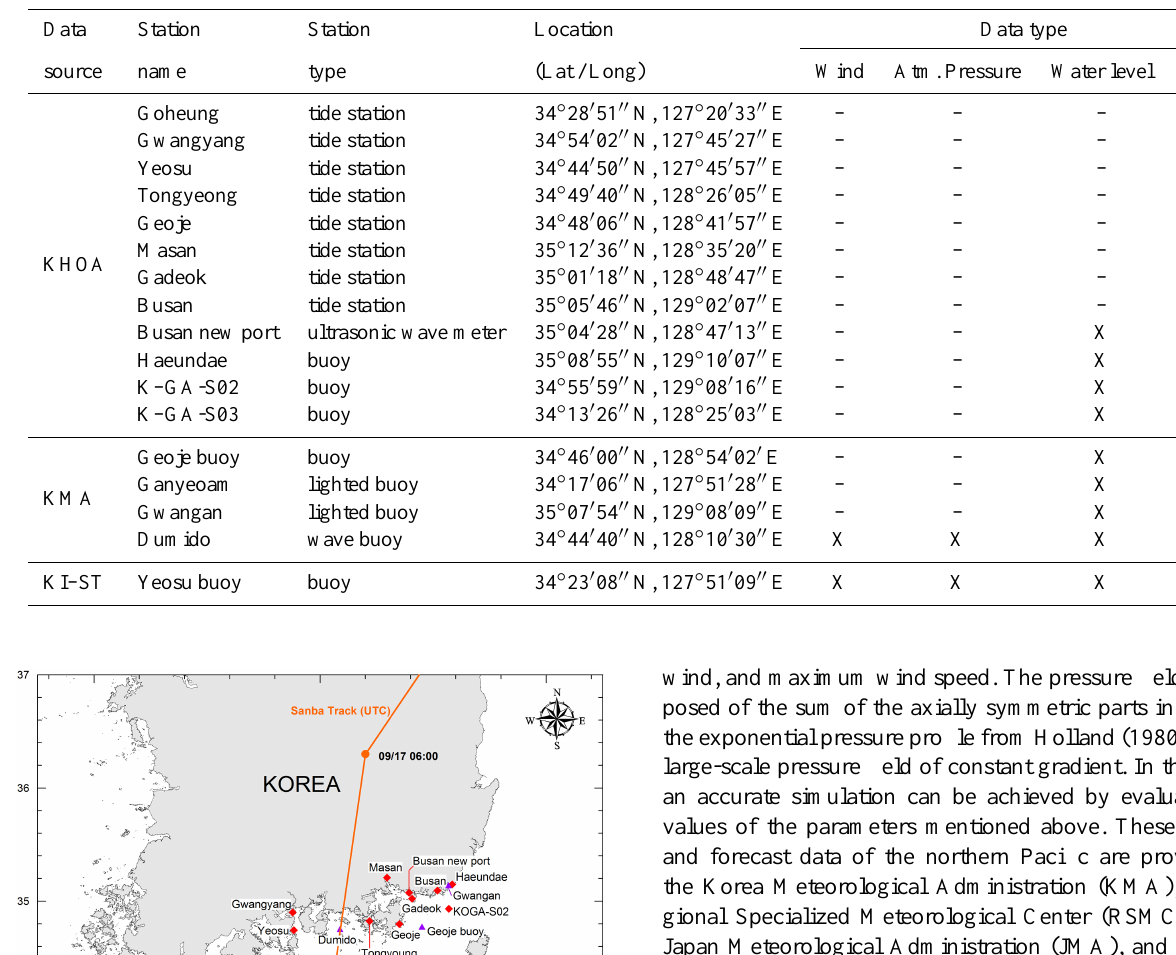
Table 1. Information from the observation stations.